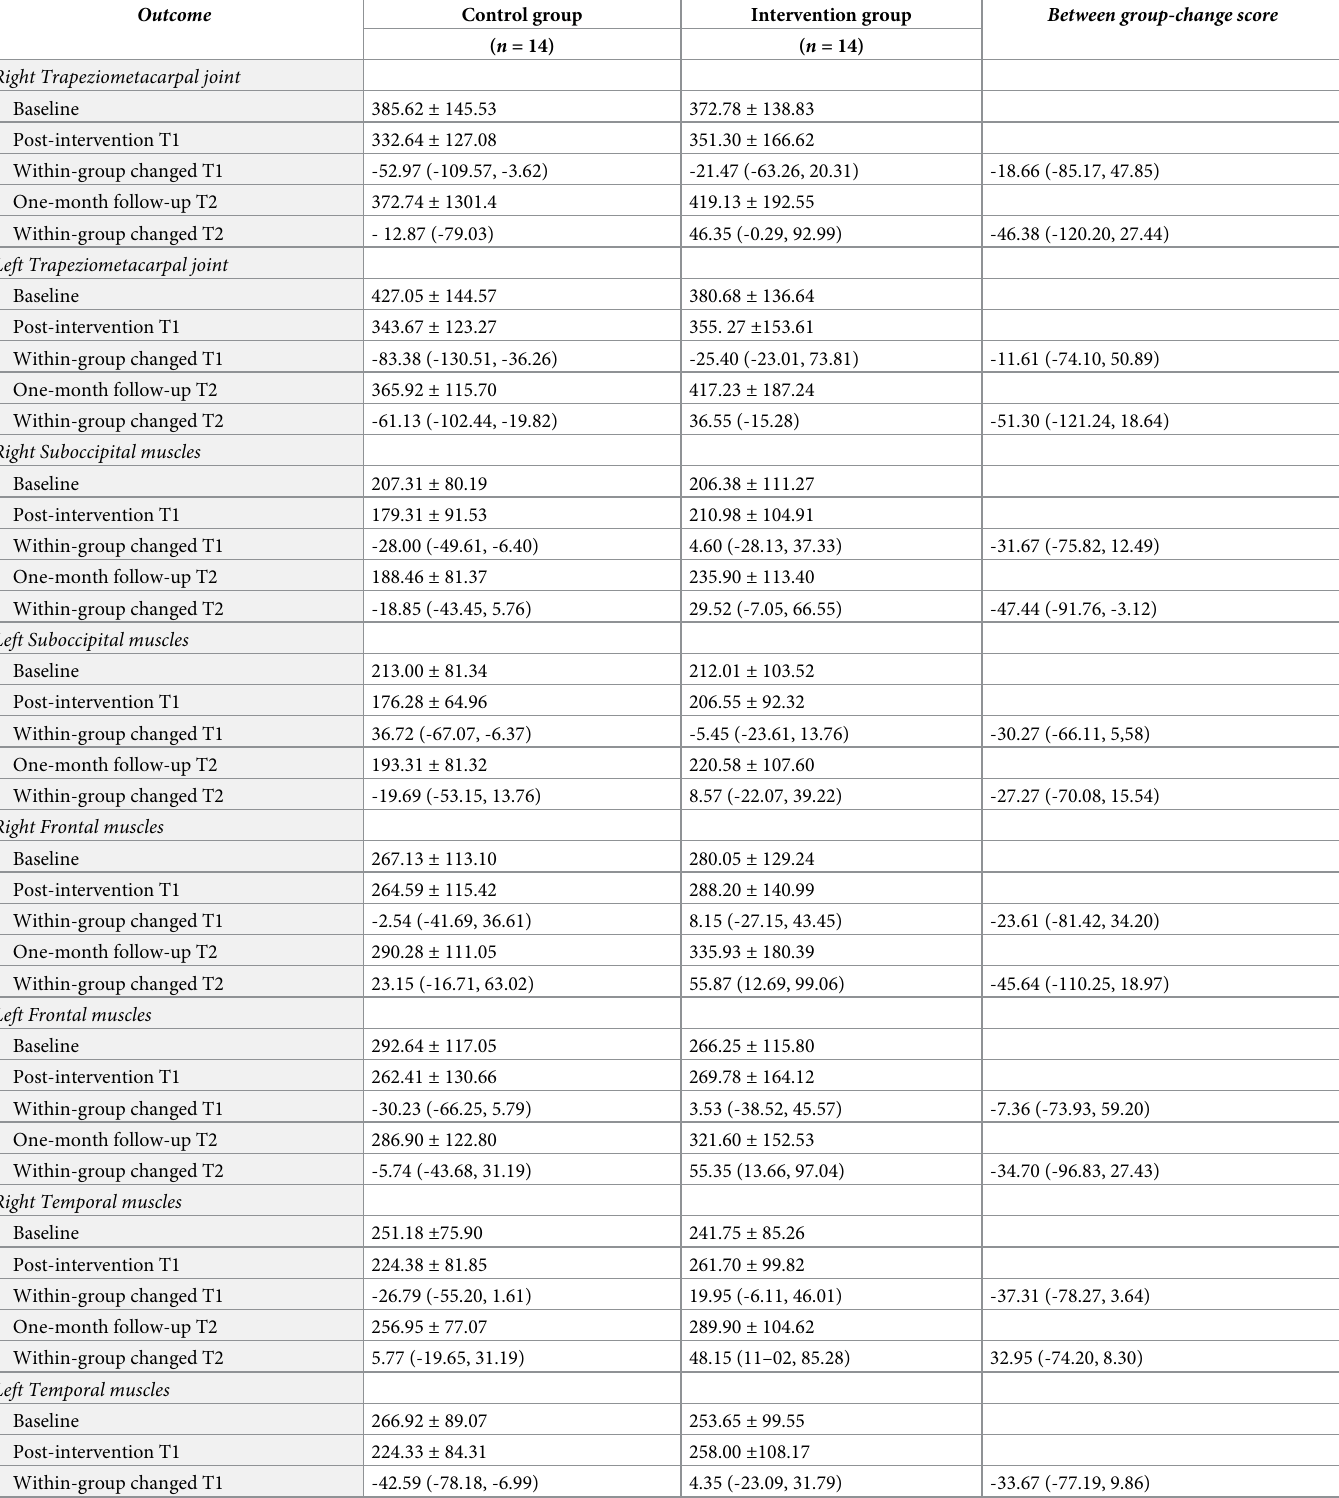
Table 4. Outcome data pressure pain